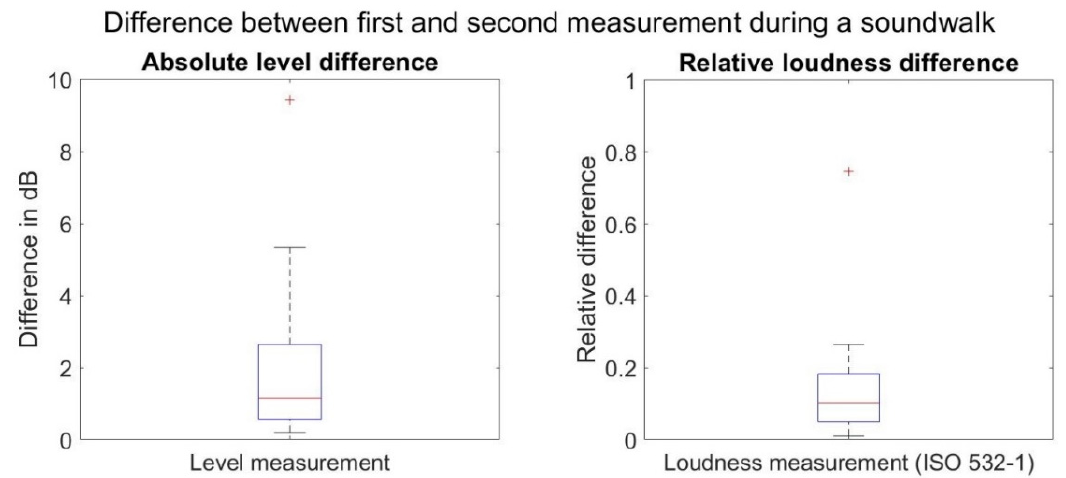
Figure 1. Boxplots displaying the level and loudness differences between the first and second visit of the same location during a soundwalk. Left: Sound pressure level differences in dB; right: Relative loudness differences in % according to ISO 532-1 [33]. The box displays the spread of data. The lower and upper box boundaries represent the 25th and 75th percentiles (interquartile range IQR), the whiskers represent the range of the remaining data up to a length of 1.5 × IQR, data falling outside the whiskers are marked as outlier values with a